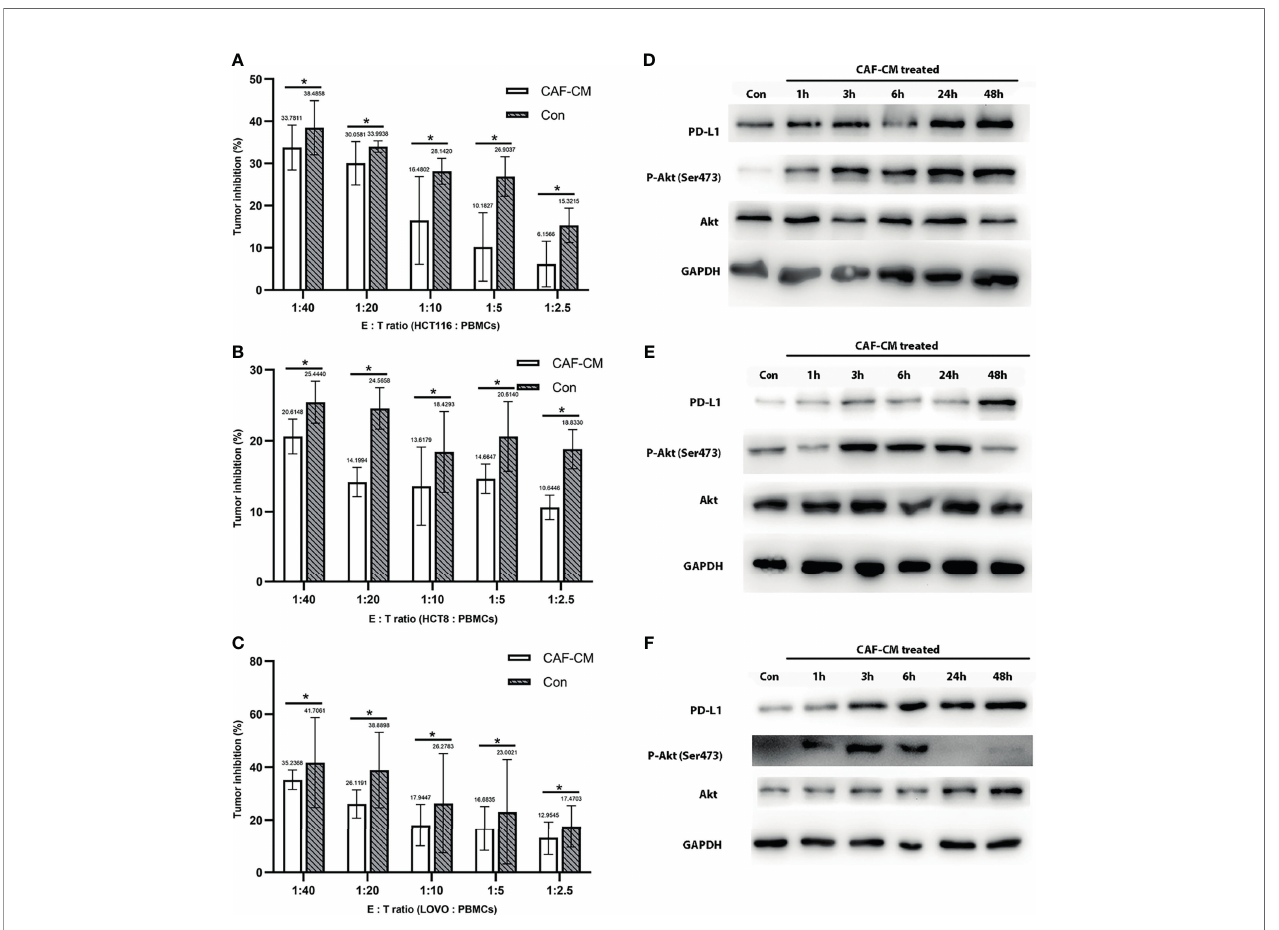
FIGURE 2 | CAFs promote the immune escape of CRC cell lines through PD-L1 upregulation. (A-C) The killing rate of HCT116, HCT8, and LOVO cultured with CAF-CM for 72h was signi fi cantly lower than cells cultured with normal culture medium (Con). (A) HCT116; (B) HCT8; (C) LOVO. (D – F) The expression of PD-L1 and p-Akt on HCT116 (D) , HCT8 (E) and LOVO (F) was upregulated after treatment with CAF-CM. Each group was replicated in 6 wells. *P <